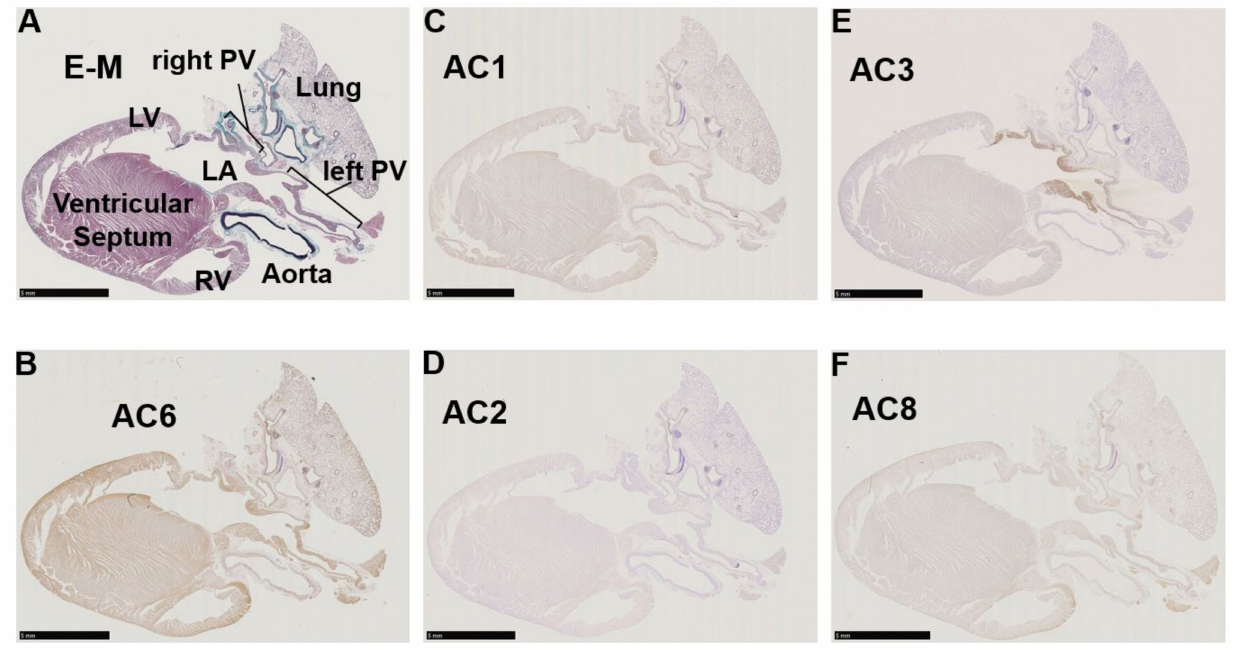
Figure 2. Immunohistochemistry of a left-sided rat heart for adenylyl cyclase AC1, AC2, AC3, AC6, and AC8. ( A ) Masson’s trichrome staining in a left-sided heart from a male Wistar rat. Muscle, collagen-enriched tissue, and elastin-enriched fibers are stained purple, turquoise, and dark blue, respectively. The cardiopulmonary regions are indicated by bold letters. LA, left atrium; LV, left ventricle; PV, pulmonary vein; RV, right ventricle. ( B ) Immunohistochemistry for AC6. AC6 is known as a heart subtype of AC and presents a positive control with solid staining (brown). ( C – F ) Immuno- histochemistry for AC1–3 and AC8. AC1 and AC8 are both moderately positive in ( C , F ). ( D ) AC2 is almost negative in the heart, while the lung epithelium is positively stained. ( E ) AC3 expression is restricted to the LA and PV. Scale bars: 5